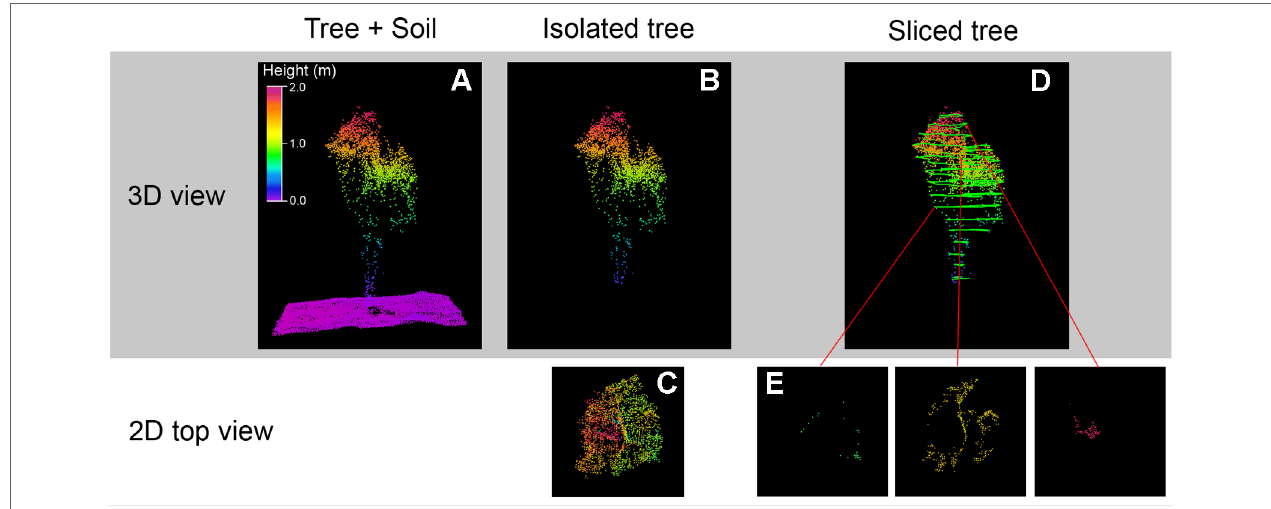
FIgUrE 4 | Graphical examples of the Object Based Image Analysis (OBIA) procedure outputs for identification and characterization of the olive seedling: (A) 3D point cloud for a square of 2 m side size, DTM is represented in pink color; (B) tree point cloud; (c) 2D representation, following the x,y axes, of the tree point cloud; (D) sliced tree point cloud along Z axis; (E) points belonging to the point cloud included in the selected slice portion.